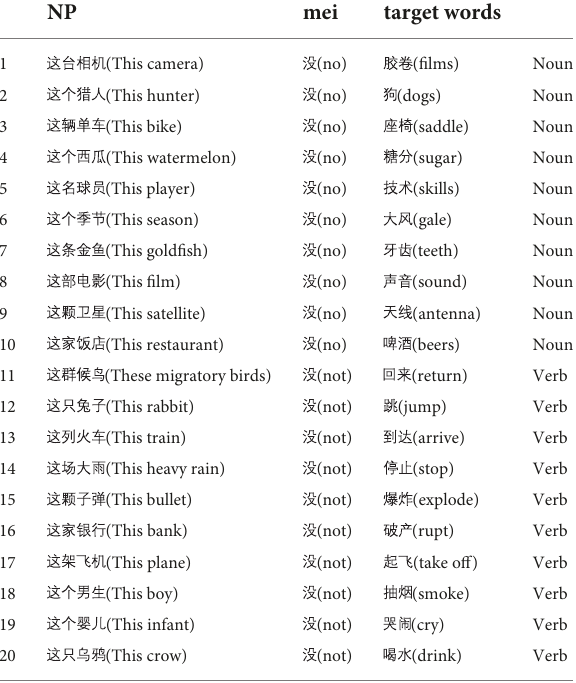
TABLE 1 Examples of Chinese sentences used as materials in Exp.